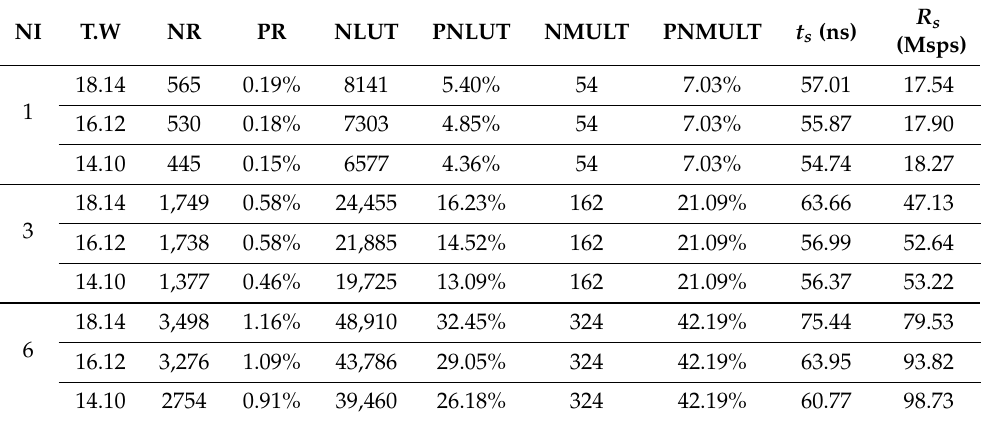
Table 6. Synthesis results regarding the hardware area occupation, processing time, and throughput for the RMLP prediction technique, varying NI and